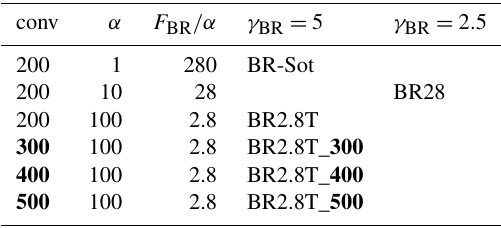
Table 1. Sensitivity settings for the collisional-breakup (BR) pa- rameterization. The conversion rate (conv) is the size (in µm) at which rimed ice crystals or snowflakes are converted to graupel, α is the scale factor, F BR is the fragments generated, and γ BR is the decay rate of fragment number at warmer temperatures. When γ BR = 5, as used in the Takahashi parameterization (Sullivan et al., 2018), then T is included in the simulation name. The bold num- bers represent the sensitivity simulations pertaining to the different conversion sizes of 300, 400 and